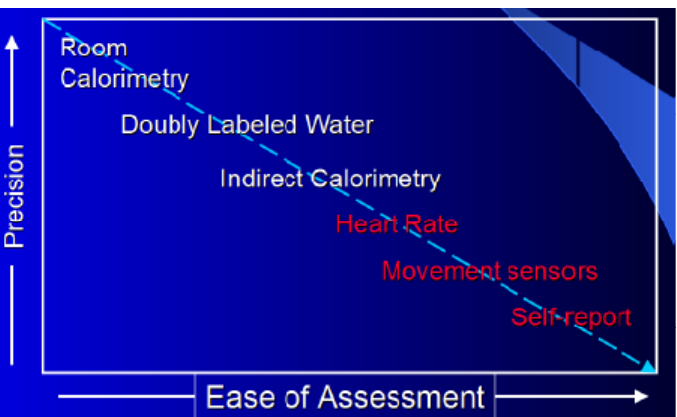
Figure 13. EE estimation